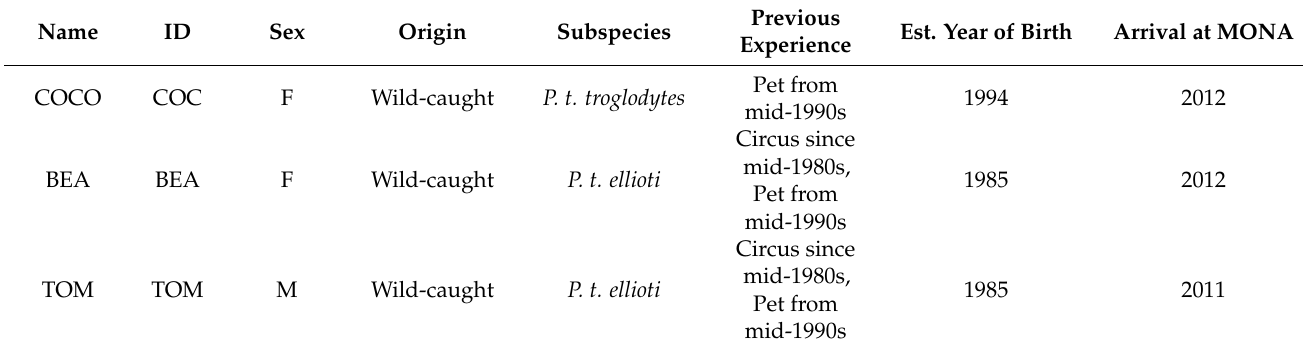
Table 1. Biographic information on the study